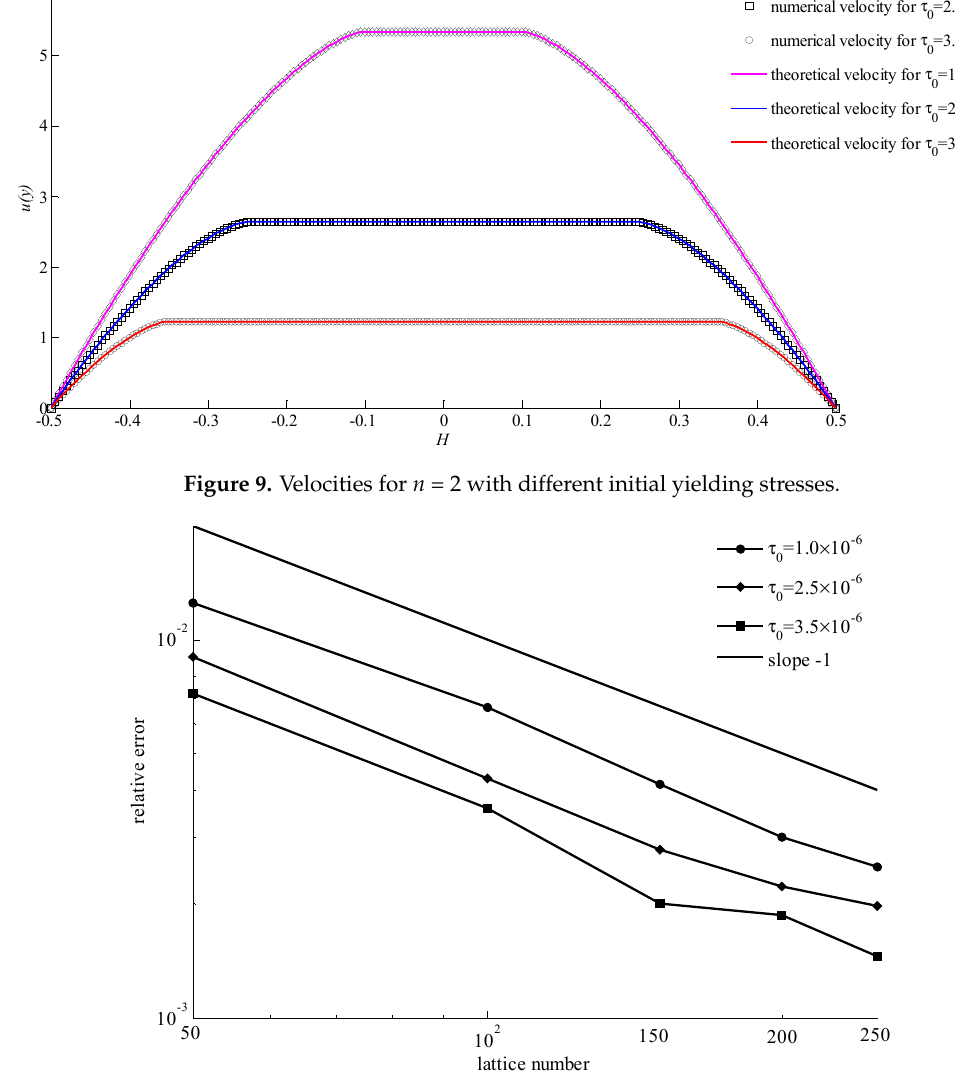
Figure 10. Relative errors for n = 2 with different initial yielding stresses and lattice numbers.